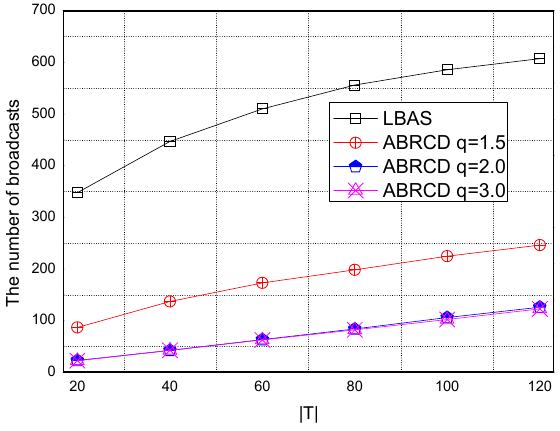
Figure 30. The impact of | T | with fixed network size = 800 on the number of broadcasts.